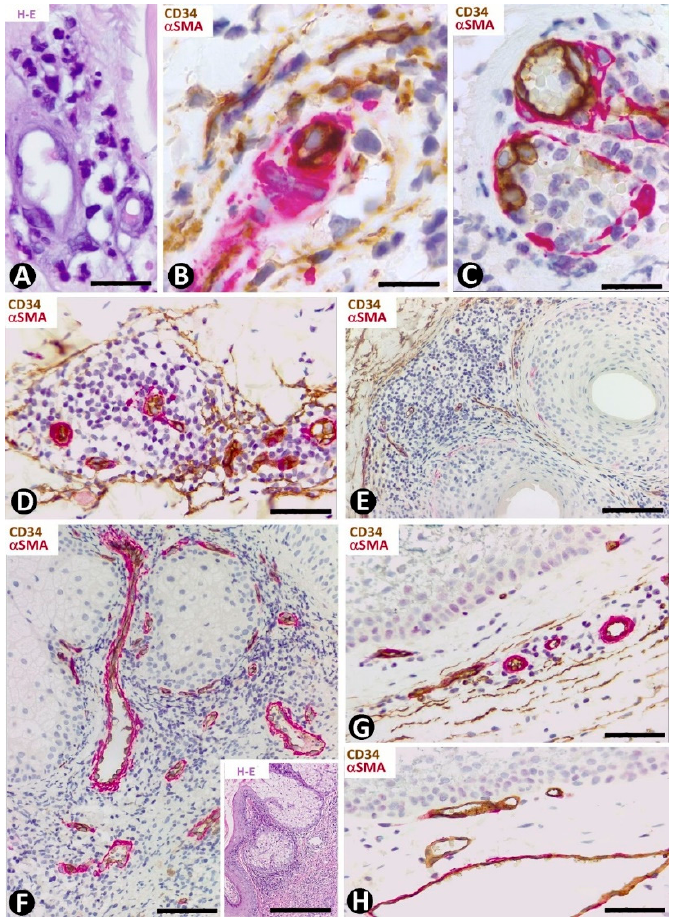
Figure 11. CD34+SCs/TCs in leukocytoclastic ( A – C ) and lymphocytic ( D ) vasculitis, perifolliculitis ( E ), rosacea ( F ) and in verruca vulgaris ( G , H ). ( A ) and insert of ( F ): Hematoxylin–eosin staining. ( B – H ) Double immunochemistry for CD34 (brown) and α SMA (red). Hematoxylin counterstain. ( A – C ) Leukocytoclastic vasculitis with nuclear dust ( A ) and with conservation ( B ) or loss ( C ) of CD34+SCs/TCs (brown) around vessels. Note in ( C ) numerous intravascular neutrophils in a vessel (arrow) and degenerative phenomena in endothelial cells with partial absence of them. ( D ) Lymphocytic infiltrate between vascular mural cells (red) and CD34+SCs/TCs (brown). ( E , F ) Inflammatory infiltrate with absence of CD34+SCs/TCs in alopecia (perifollicular) ( E ) and in rosacea (around sebaceous glands) ( F ). ( G , H ) Verruca vulgaris with presence ( G ) or absence ( H ) of interstitial and perivascular CD34+SCs/TCs (brown). Bar: ( A , B , C ) 45 µm, ( D , F , G , H ) 80 µm, ( E ) 150 µm.